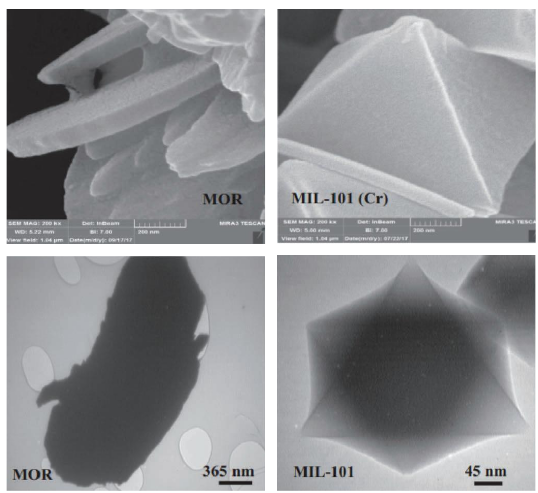
Figure 22: SEM Images of MIL-101 and MOR zeolite adopted from